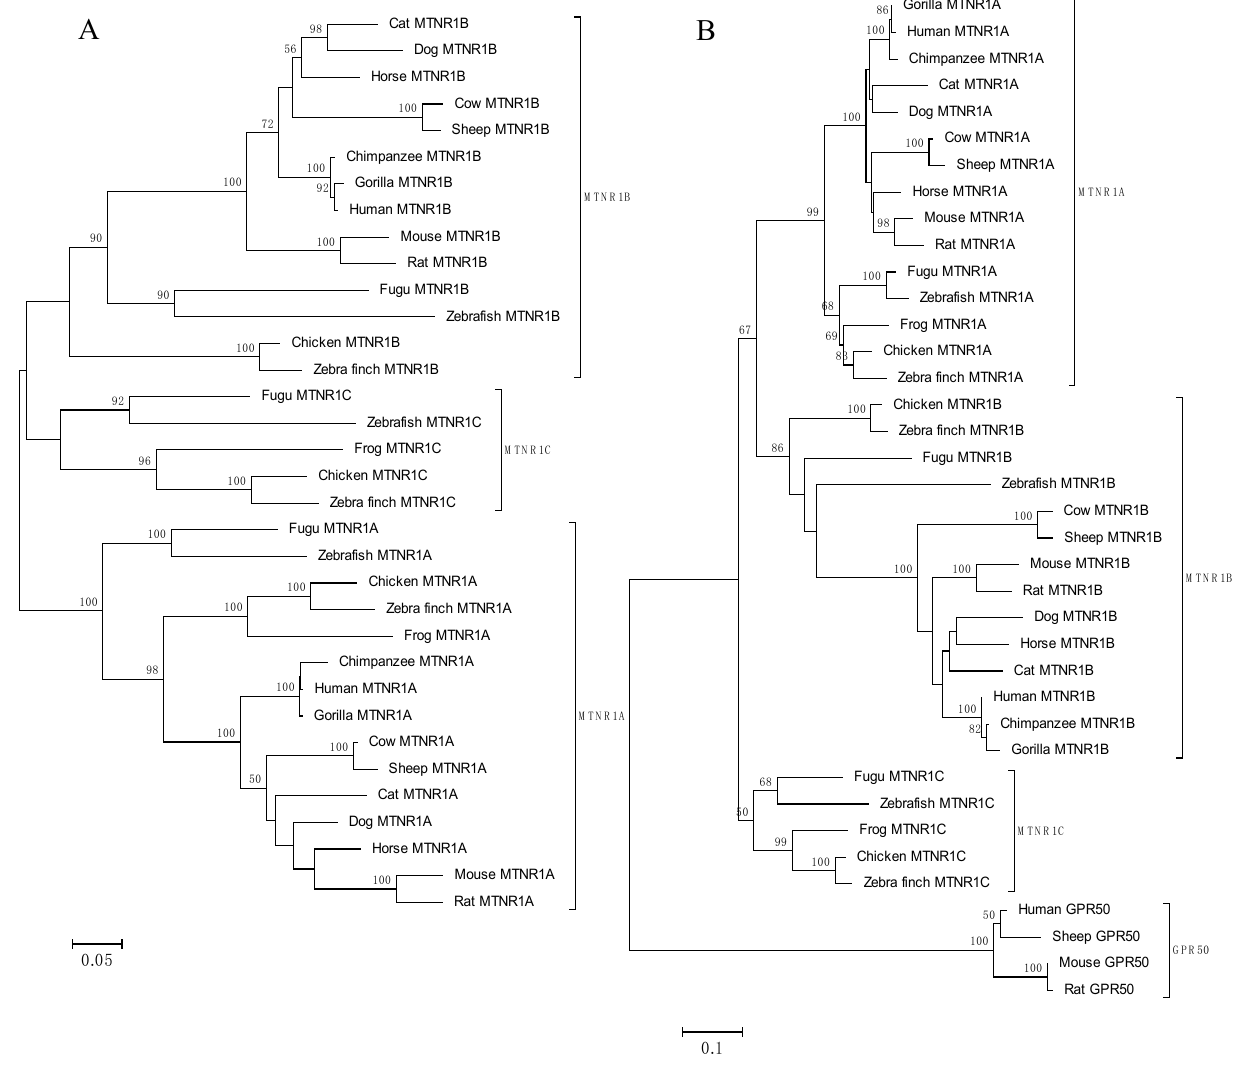
Figure 3. Neighbor-Joining (N-J) tree of melatonin receptors (panel A ) constructed with protein Poisson distances; N-J tree of melatonin receptors and GPR50 (panel B